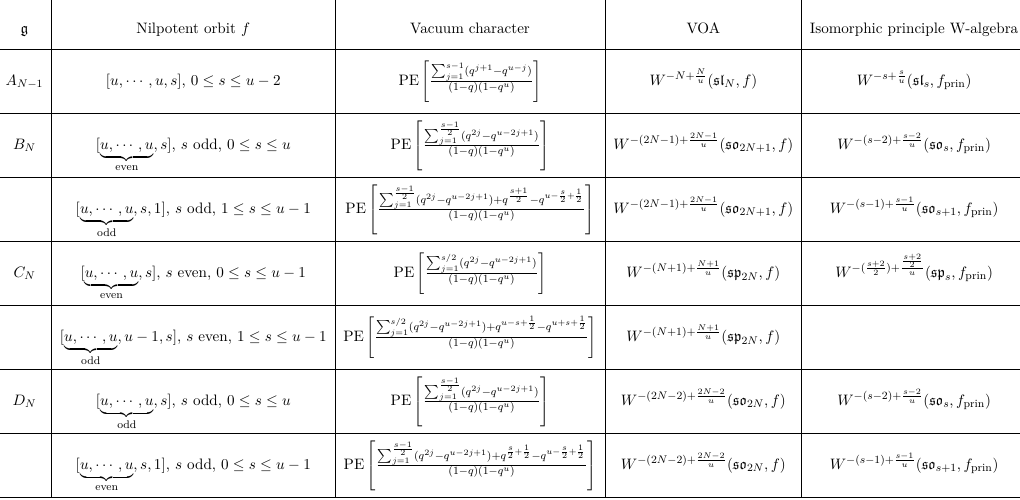
∨ ( g , f ) , where g is classical lie algebra. u u